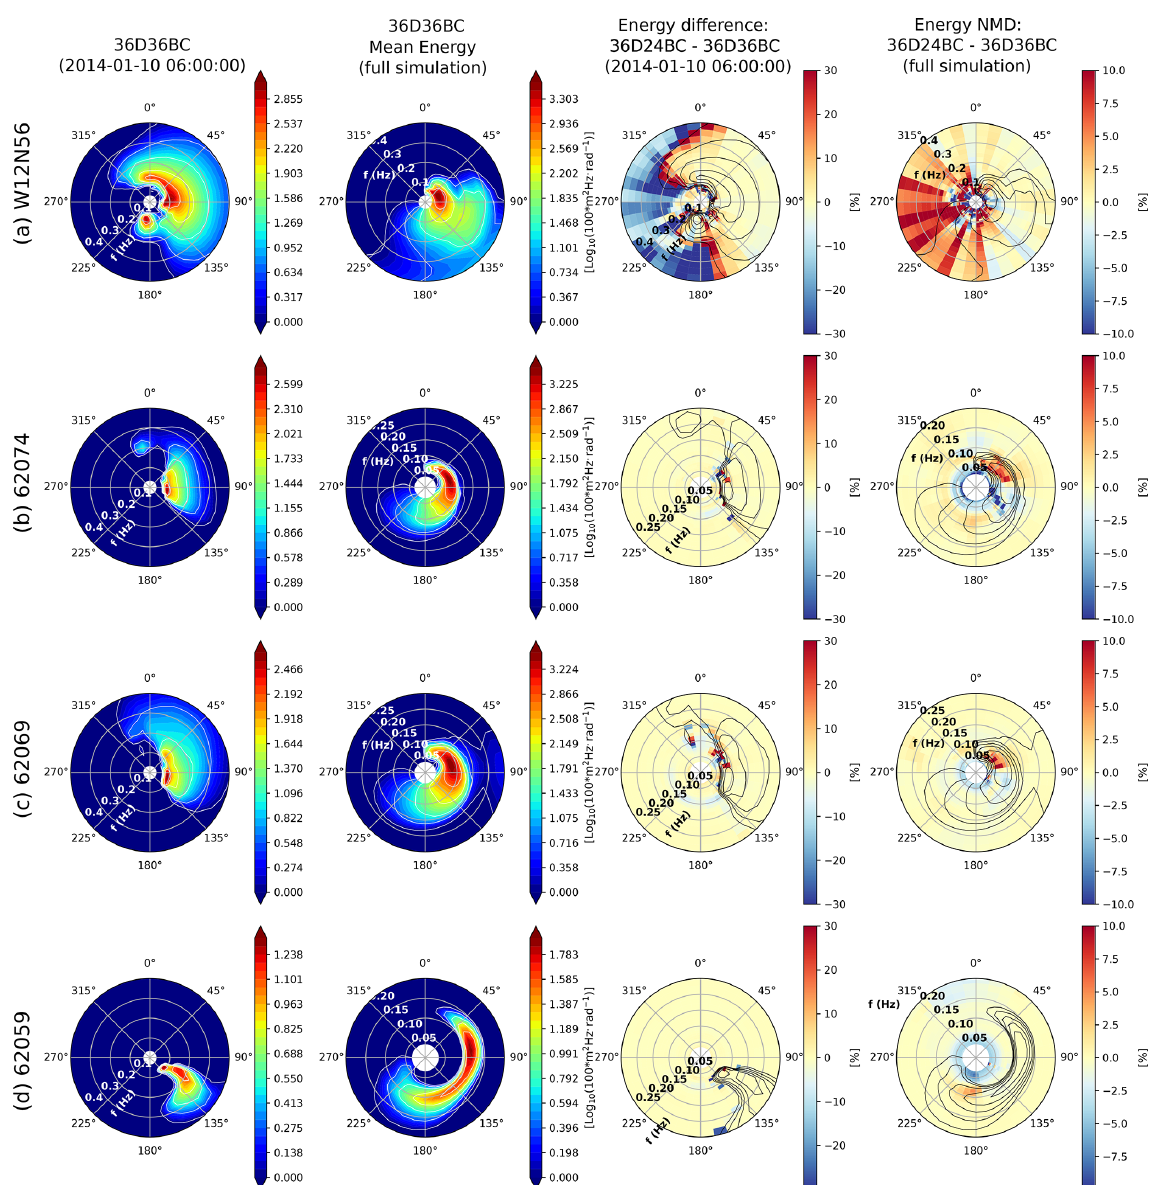
Figure 11. Effects of boundary conditions with lower directional resolution at different output locations. (a) Boundary node W12N56 (long: 12 ◦ ; lat: 56 ◦ ) (b) 62074 (Belle Ile), (c) 62069 (Pierres Noires), and (d) 62059 (Cherbourg). Absolute and normalized differences (36D24BC − 36D36BC) computed for January 2014. White contours marking energy levels in the left panels are overlaid in black in the difference plots. The direction convention defines the travel direction of the